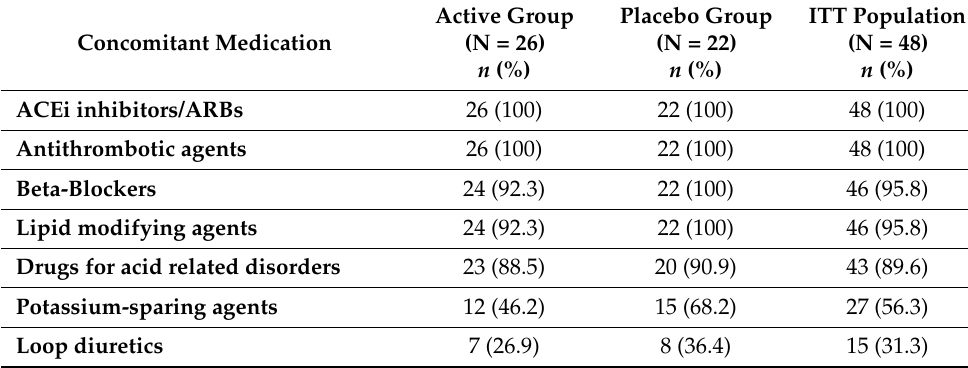
Table 2. Summary of Concomitant Medications (ITT